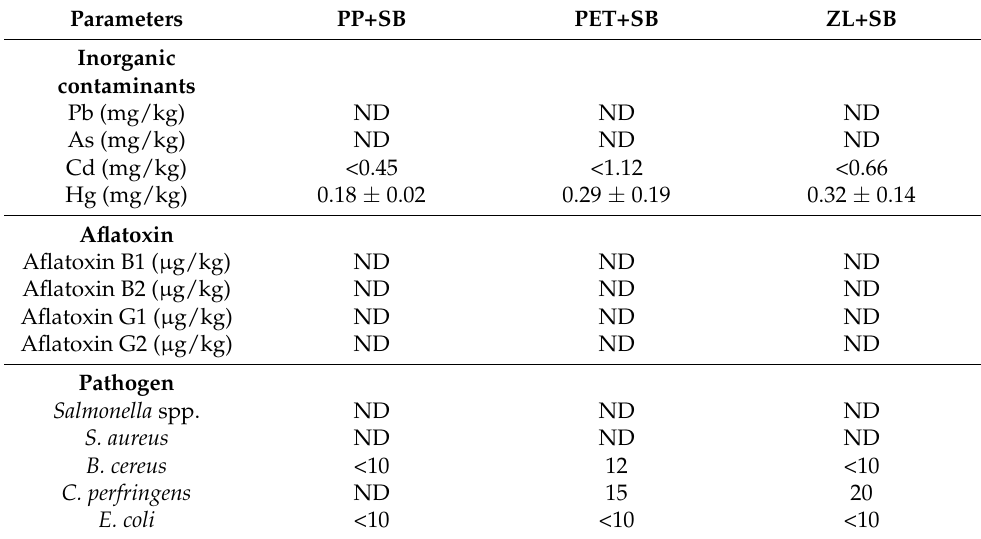
Table 6. Inorganic contaminants, aflatoxin, and pathogens in dried chili fish paste stored in the chosen packaging at the 20th week of room-temperature